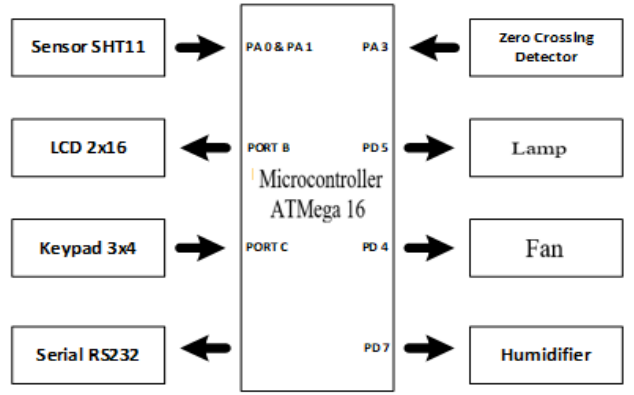
Figure 4. Input relation dan microcontroller port output.